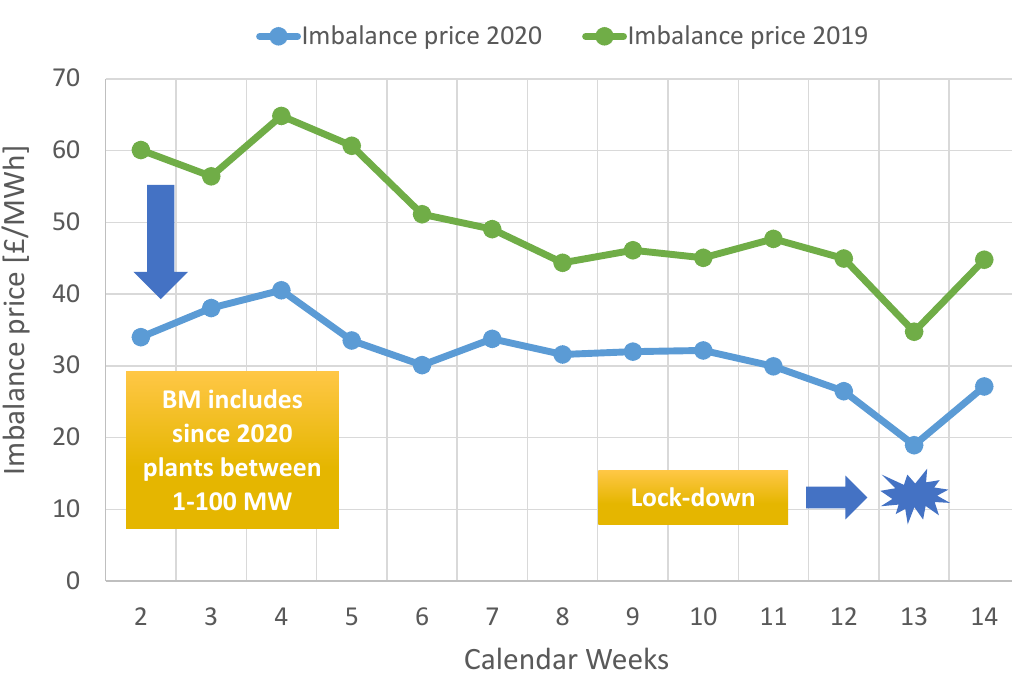
Figure 16. The impact of lower demand on the imbalance price is not clear. Variation and trends observed in both 2019 and 2020 are similar. The observed price difference between the years is caused by wider access to balancing